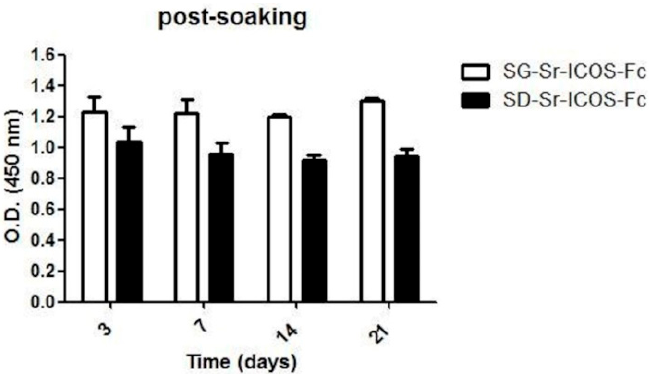
Figure 11. ELISA-like assay conducted on SG-Sr-ICOS-Fc and SD-Sr-ICOS-Fc post soaking in DMEM collected at different time steps (3, 7, 14 and 21 days). The presence and the binding of ICOS-Fc were detected by ELISA-like assay using the human ICOSL-His as capture protein and anti-human-Hrpas detection antibody. The graph shows the Optical Density (OD) values (mean and standard error were obtained from three separate samples).